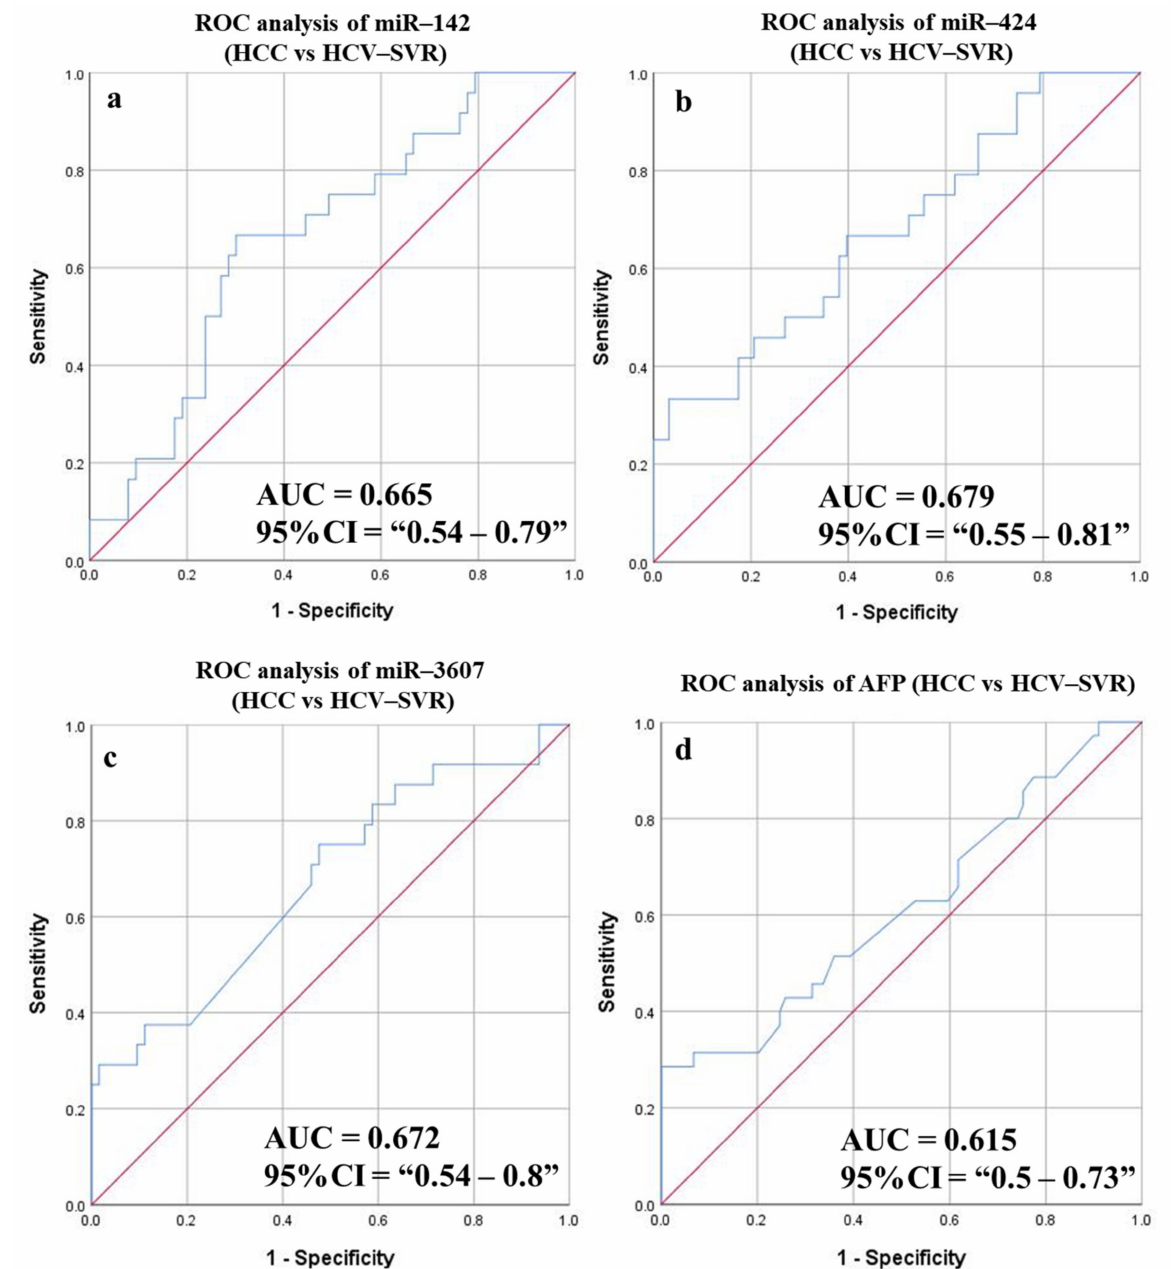
Figure 12. ROC curves and AUC for DE-miRNAs compared to AFP to differentiate between HCC (SVR) and HCV (SVR) patients. The diagnostic potential and AUC of three DE-miRNAs [( a ) miR-142 ( b ) miR-424 and ( c ) miR-3607], in addition to ( d ) AFP, were calculated. (AFP: Alpha-fetoprotein, DE: Differentially expressed, HCC: Hepatocellular carcinoma, ROC: Receiver operating characteristic). The ROC curve corresponding to the combined panel in each scenario were con- structed and the AUC was calculated to assess the diagnostic potentials of the combined panels (Figure